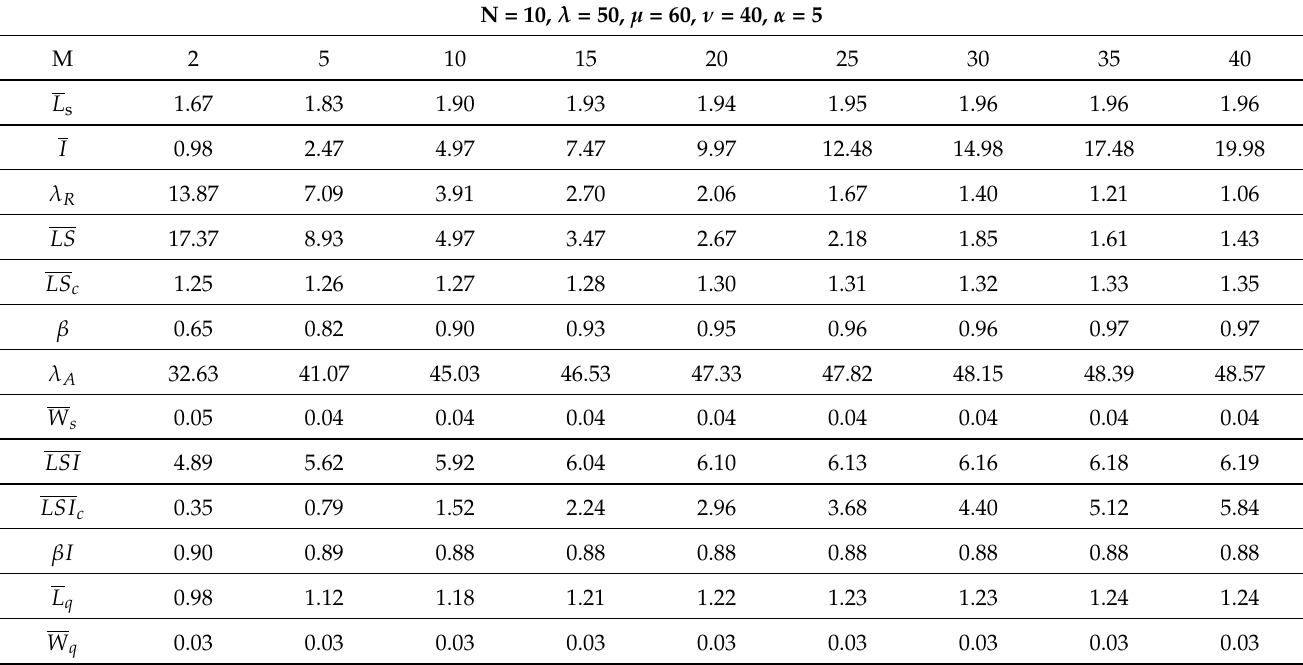
Table 3. Effect of changing the order quantity on the performance measure when the maximal capacity of the system is ten and the maximal capacity of the inventory is variable with impatient customers under a deterministic order size.